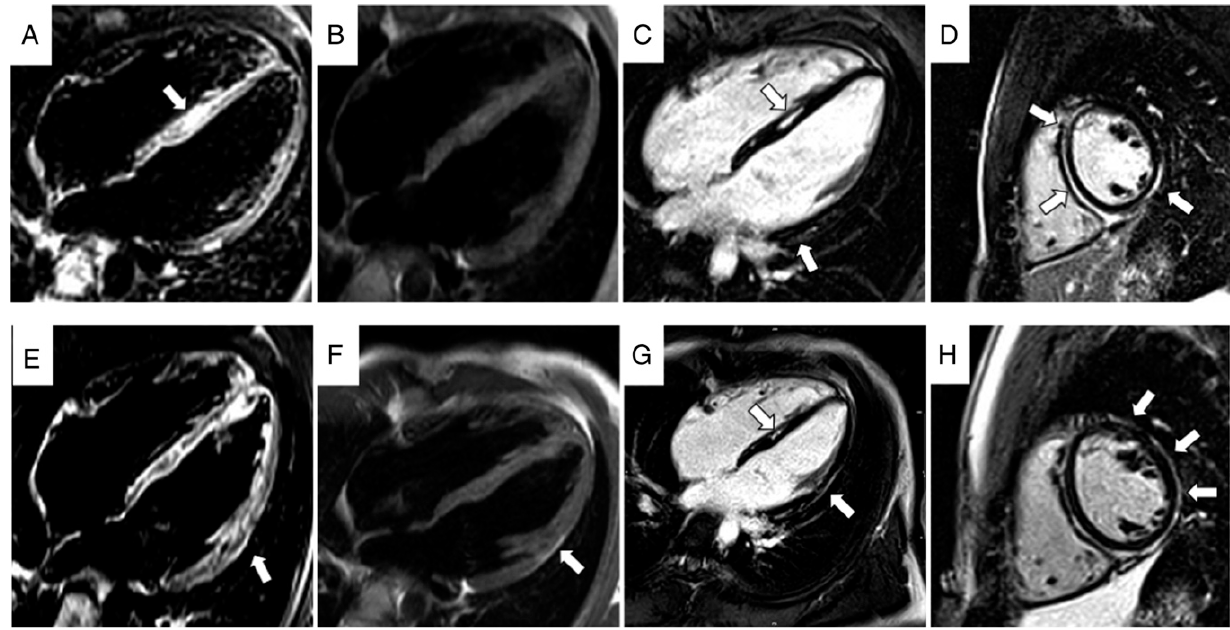
Figure 2. CE-CMR images obtained during two different episodes of chest pain, with 3 years interval [first episode ( A – D ) and last episode ( E – H )]. In ( A , E ), note the presence of oedema (arrow) in the septum ( A ) and in the lateral wall of LV ( E ). In ( B , F ) turbo spin echo sequences demonstrate the evolution with appearance of a fat subepicardial stria in lateral wall of LV (arrow). Inversion recovery sequences obtained after administration of contrast agent ( C , D , G , H ): note the extension of fibrosis from septum and inferior wall to lateral wall during years (arrows). LV, left ventricle. Reproduced with permission from Bariani et al., Europace, 2021 [8].